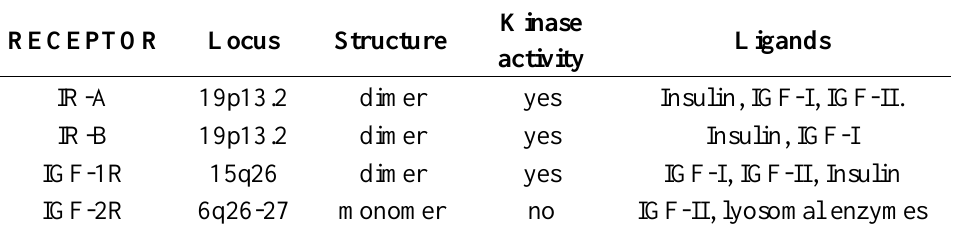
Table 4. Insulin receptor family members and its